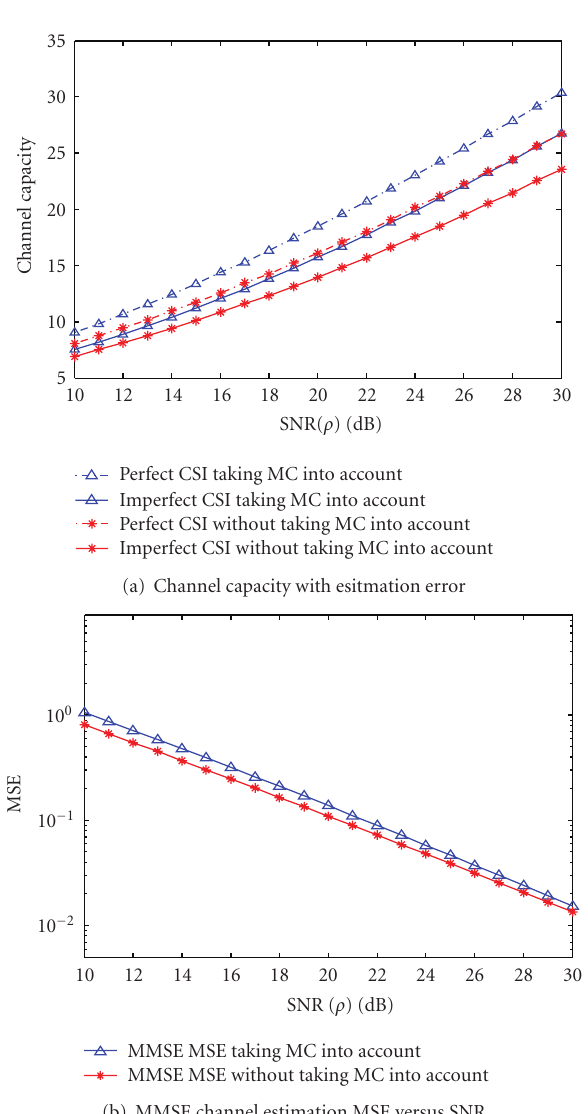
Figure 3: (a) Channel capacity considering MMSE estimation error for a 4 × 4 MIMO under mutual coupling e ff ect versus SNR. (b) MMSE MSE performance for a 4 × 4 MIMO under mutual coupling e ff ect versus SNR; transmitter antenna spacing is set to 0. 1 λ , receiver antenna spacing is set to 1 λ